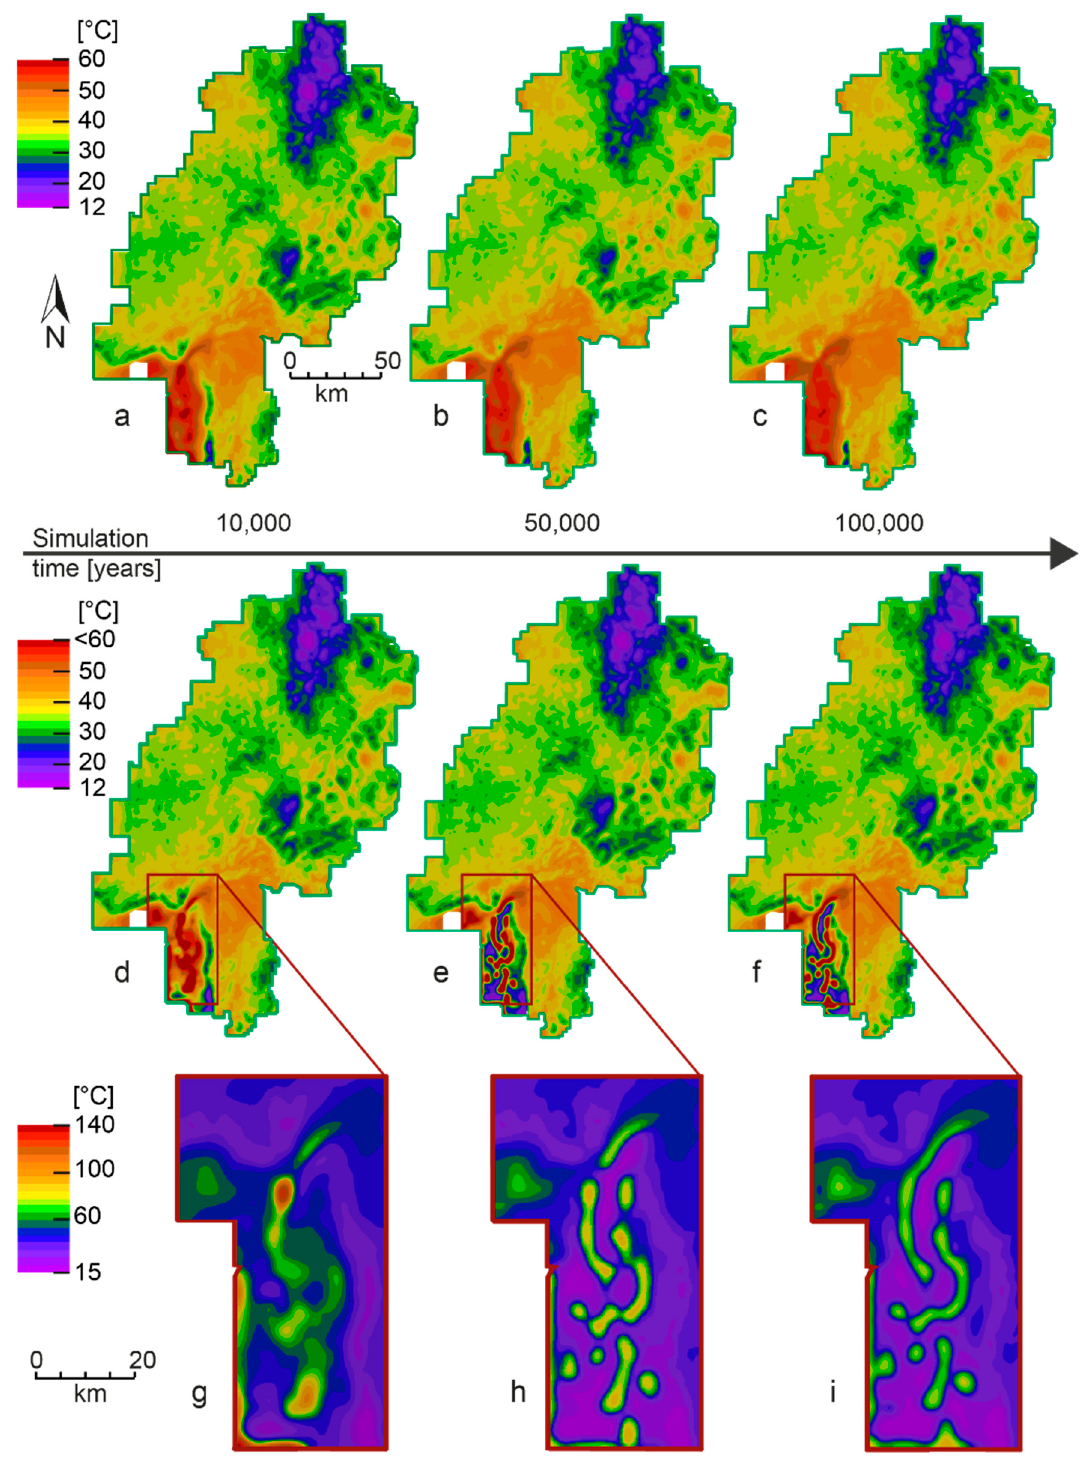
Figure 10. Maps of temperature at 1 km depth. ( a – c ) results of coupled thermo-hydraulic simulations with constant viscosity and density after (a) 10,000, (b) 50,000 and (c) 100,000 years. ( d – f ) results of coupled thermo-hydraulic simulations with temperature and pressure dependent varying viscosity and density after (d) 10,000, (e) 50,000 and (f) 100,000 years. The south-western model area is shown in ( g – i ) in a zoomed view with different color scales, to better identify the temperatures in the thermal anomalies.